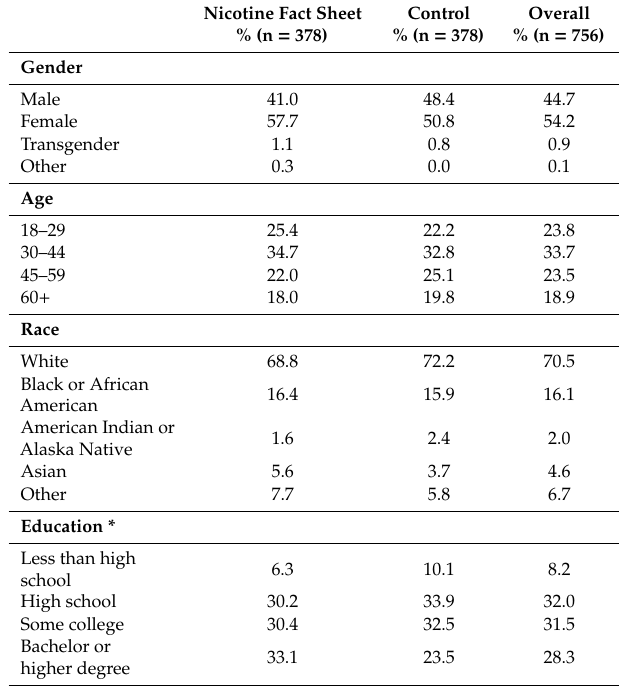
Table 2. Characteristics of study participants by conditions and